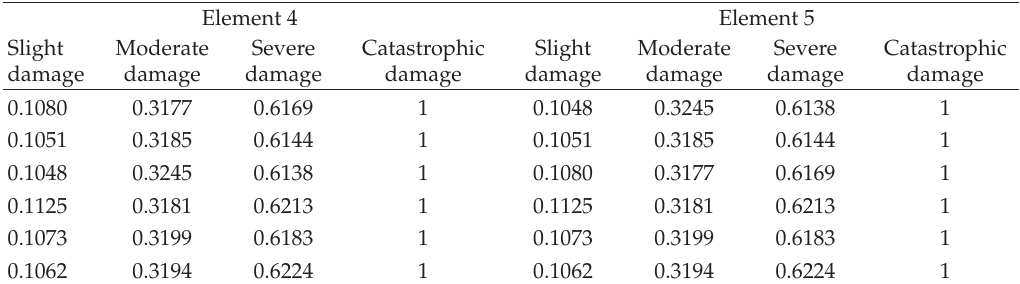
Table 3: Knowledge base for damage identification of element 4.